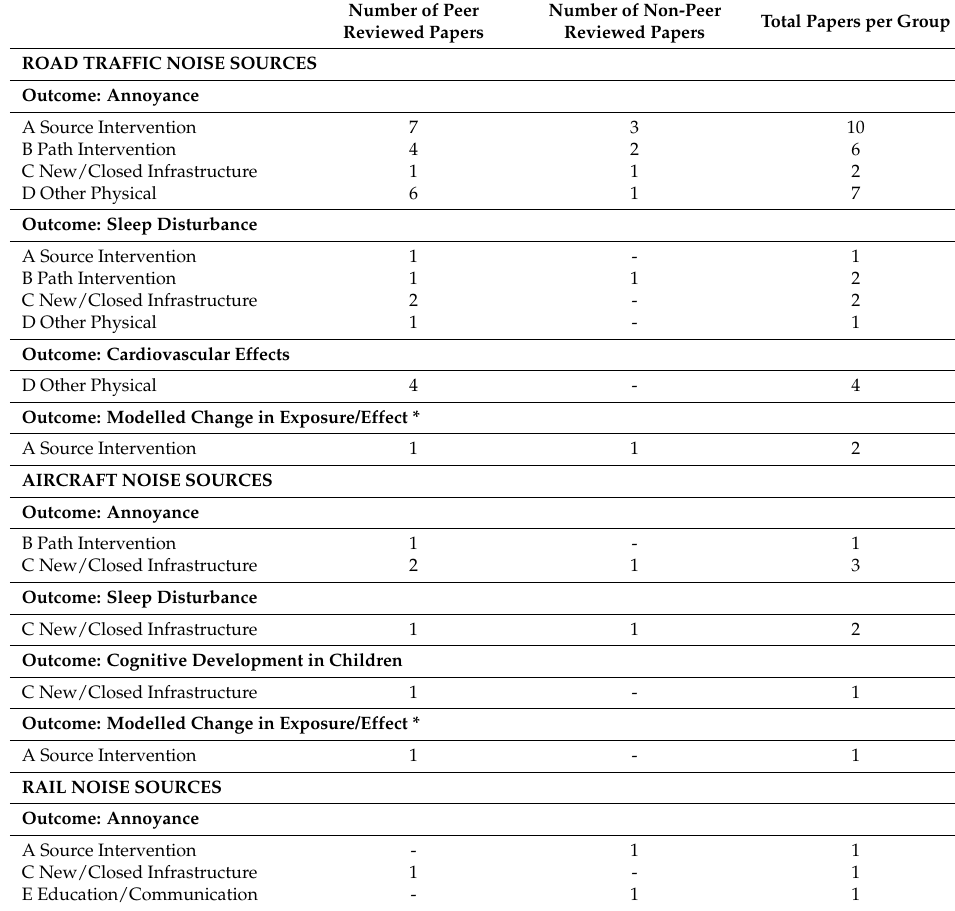
Table 2. Number of Individual Studies within each Group (Noise Source × Outcome Measure × Intervention